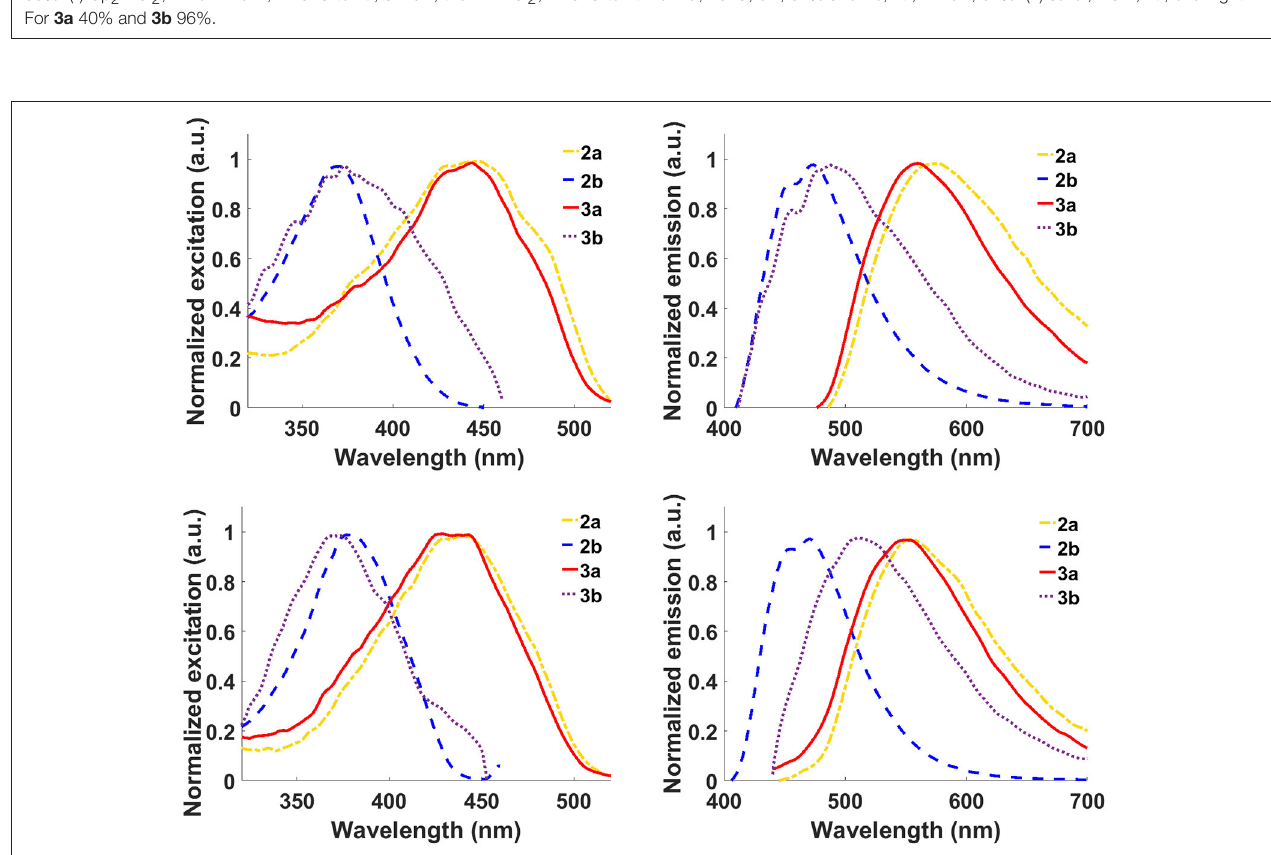
FIGURE 2 | Optical characterization of the phospholes. Normalized excitation spectra (left column) and emission spectra (right column) of probes 2a,b and 3a,b in phosphate buffer saline pH: 7.4 (PBS) with 0.7% DMSO as co-solvent (top) and DMSO (bottom). Normalization was done with respect to the emission maxima. Ligands 2a and 3a were excited at 420nm and 2b and 3b at 390nm.